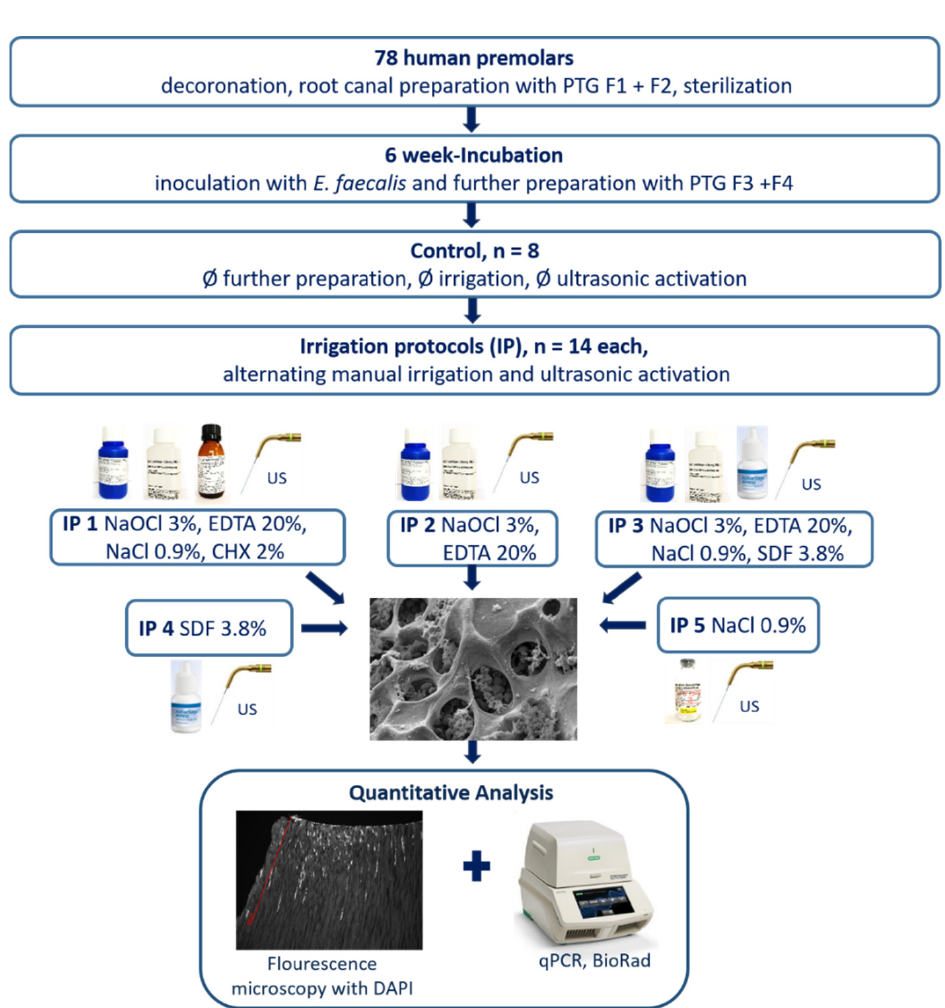
Figure 1. Flow-chart of the experimental setup. In total 78 human premolars were decoronated, the root canal was prepared with rotary nickel-titanium files Pro Taper Gold (PTG) F1 and F2, and the roots were sterilized and embedded in agarose. Then an inoculation with E. faecalis followed